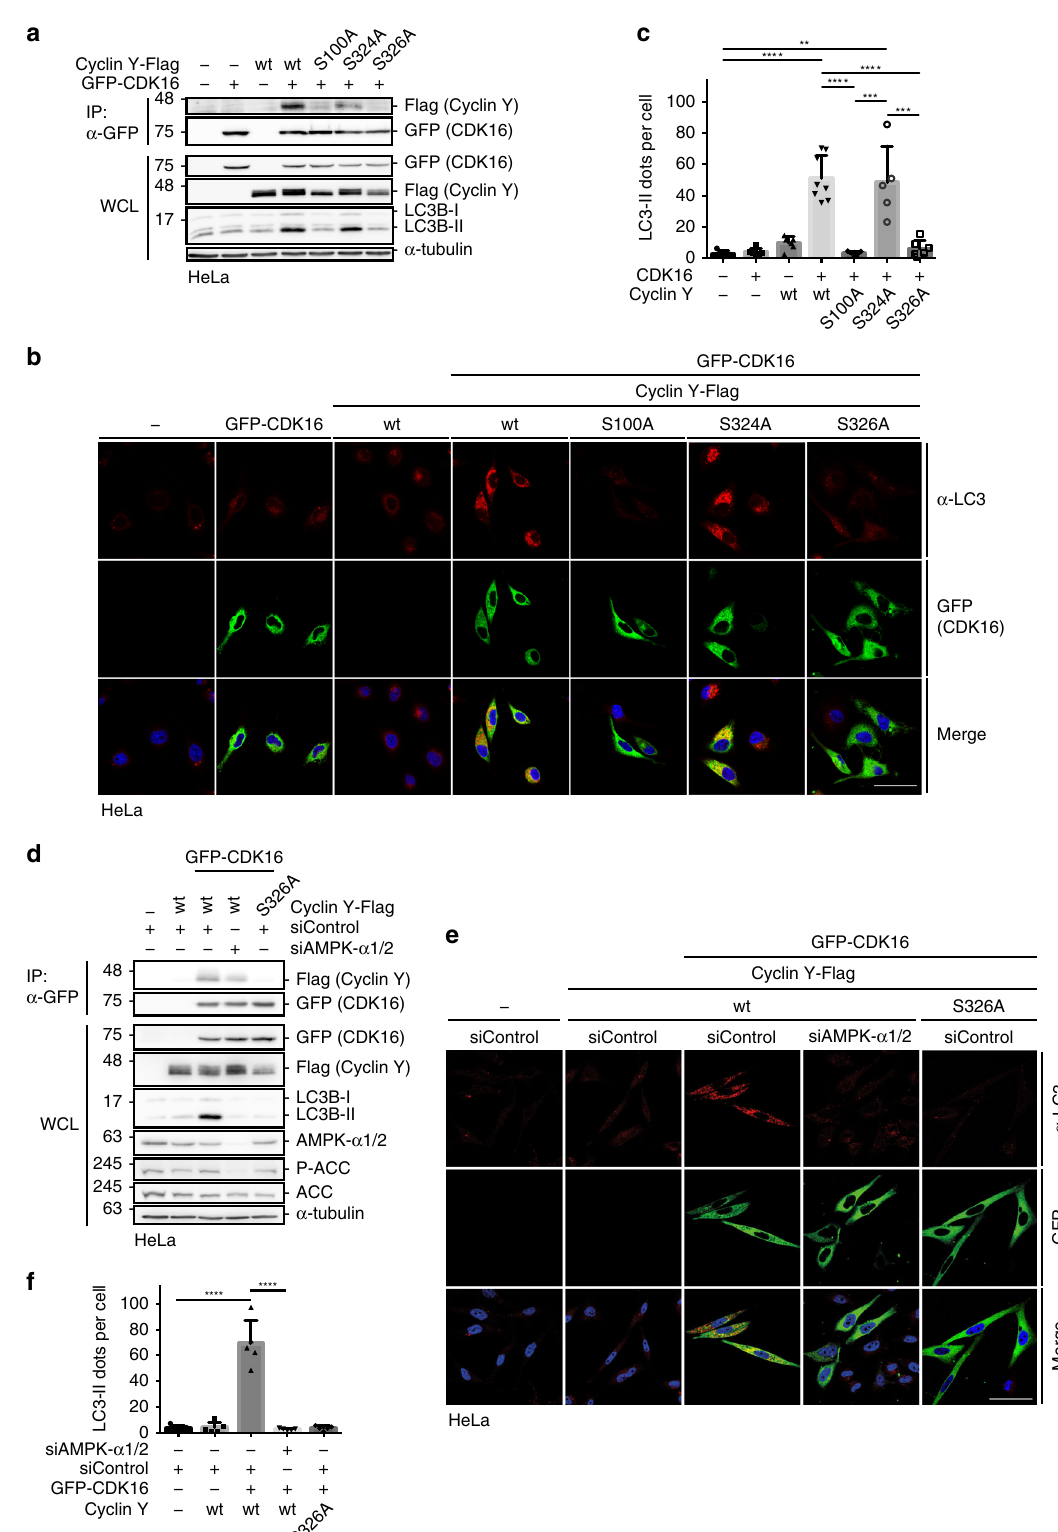
GST-tagged protein expression and puri fi cation . Puri fi cations of GST-tagged proteins were generally performed using the E.coli BL21 strain. After